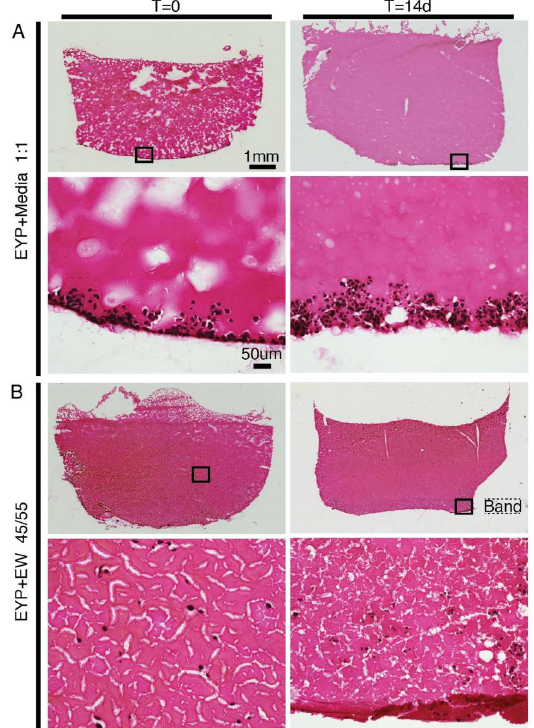
Figure 1. NS-SV-AC cells in EYP Biomaterial combinations analyzed at 0 and 14 days. In panels of biomaterial combinations, either EYP + Media or EYP + EW, images taken by microscopy show 25× (upper panel) and 200× (lower panel) magnification of the sagittal sections grown in 3D-Cryo well inset. Sirius Red Chemical Stain was used to stain sagittal sections. Biomaterials were in red/pink, while cells were in black. ( A ) Cells in EYP + Media 1:1 mixture; ( B ) Cells in EYP + EW 45:55 mixture. The word “band” highlights the approximate thickness of the sagged protein network in the EW at T = 14 d.